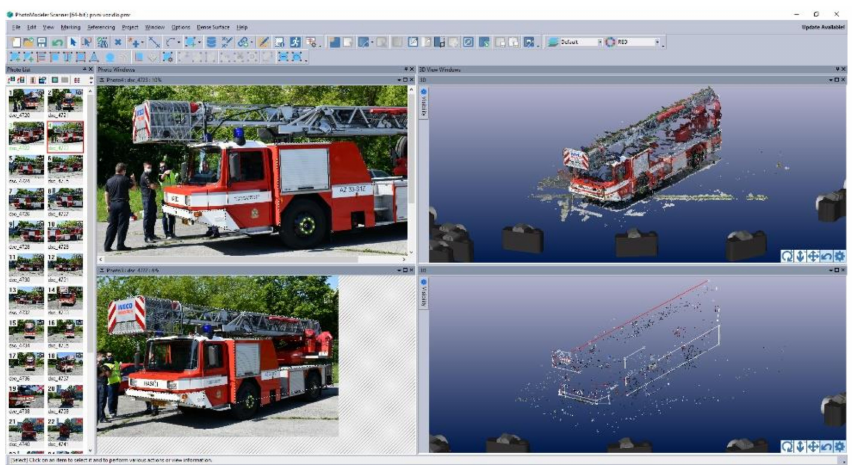
Figure 7. Photogrammetric measurements of the characteristic dimensions of the FRS ladder truck in Photomodeler Scanner.